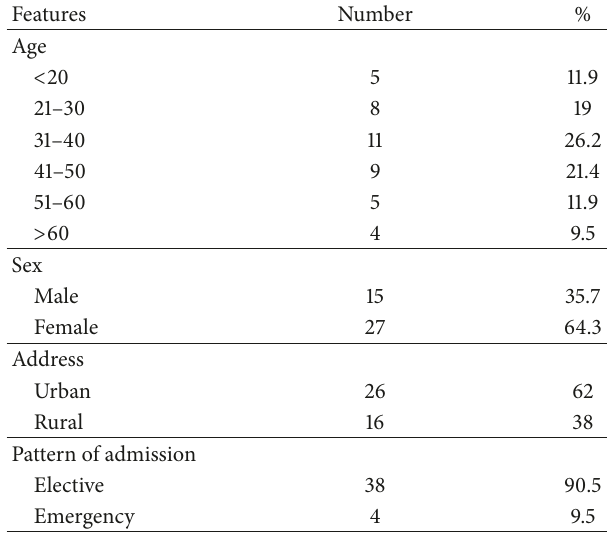
Table 1: Sociodemographic characteristics of patients operated on for intra-abdominal hydatid cyst, SPHMMC, 2015.